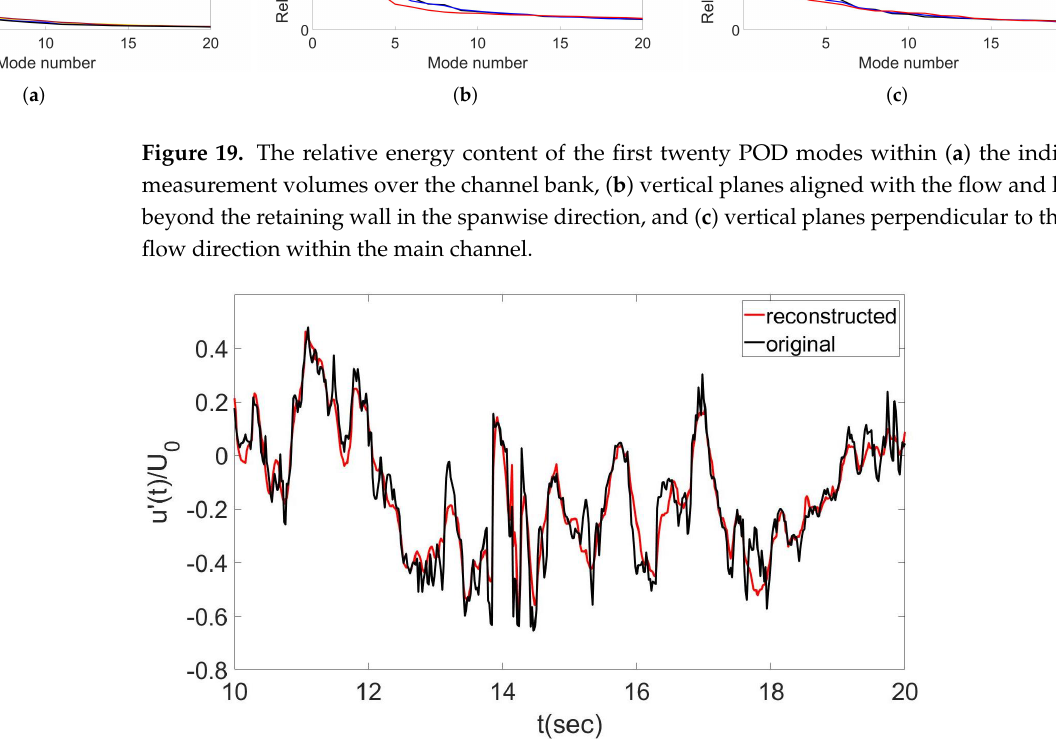
Figure 20. Reconstruction of the dimensionless streamwise velocity fluctuations (red line) using the first ten POD modes, compared to the original data (black solid